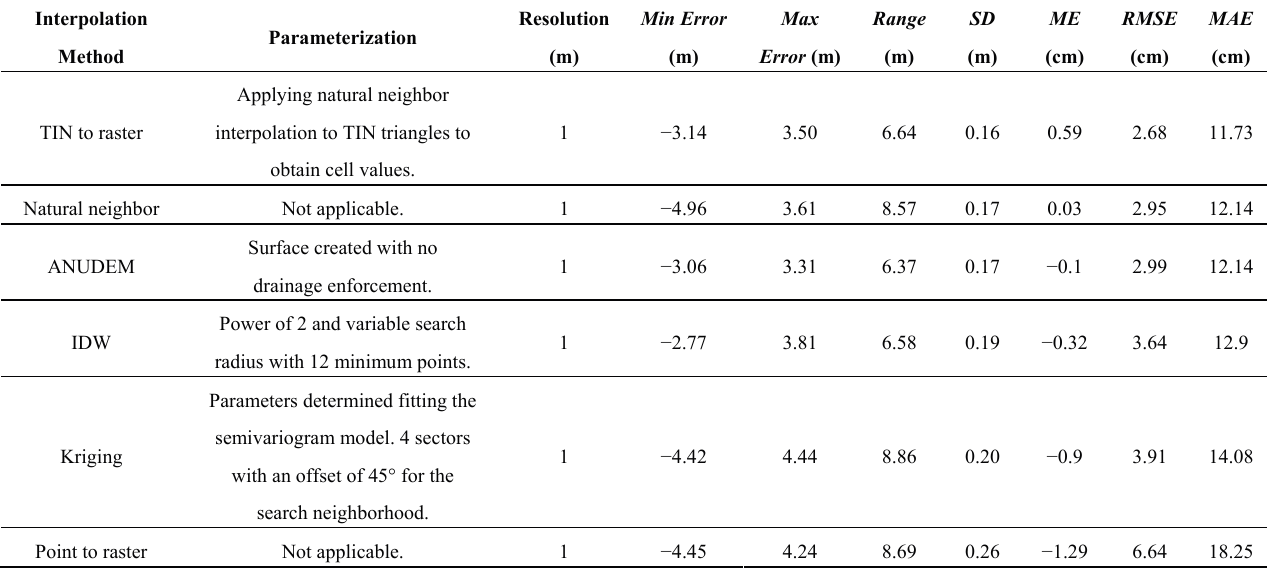
Table 3. Global statistics summarizing validation errors obtained with the ALS training dataset. Only the most accurate parameterization values for all the methods applied at both resolutions (1 and 2 m) are analyzed. Mean Error ( ME ), Mean Absolute Error ( MAE ), Root Mean Square Error ( RMSE ) and Standard Deviation of residuals ( SD ). Interpolation methods are ranked from lowest to highest RMSE . N =